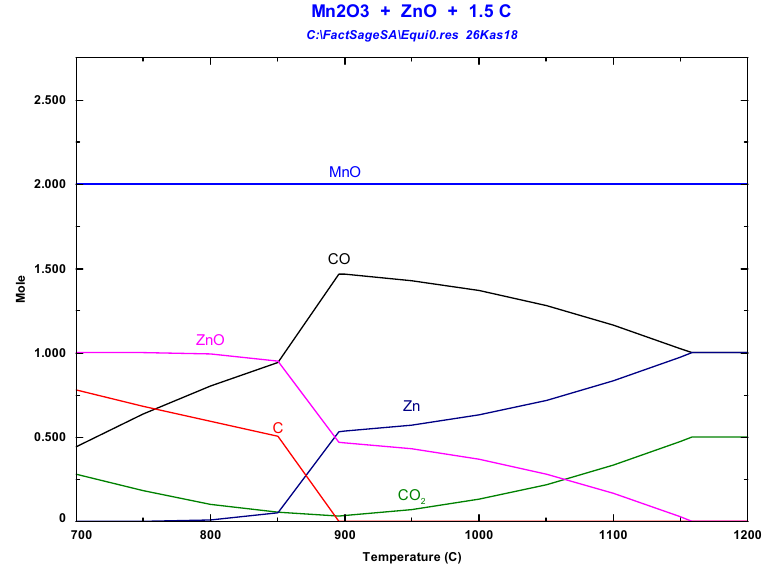
Figure 4. The change of reaction products with increasing process temperature for 1 atm condition.